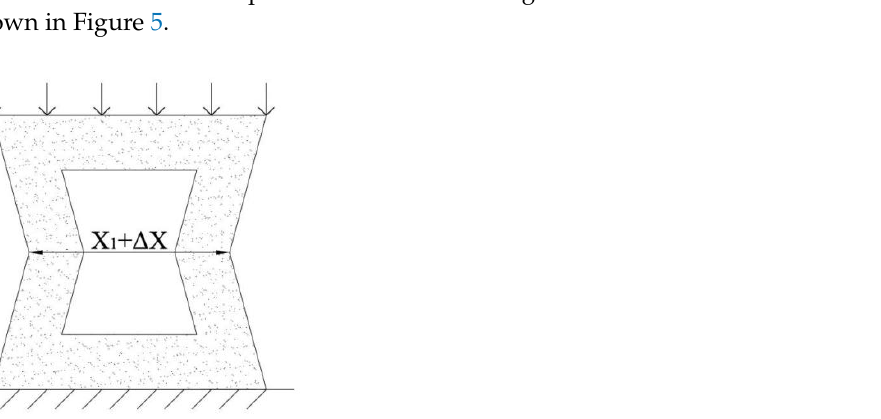
Figure 5. Schematic diagram of deformation measurement of the concave hexagonal unit cell.